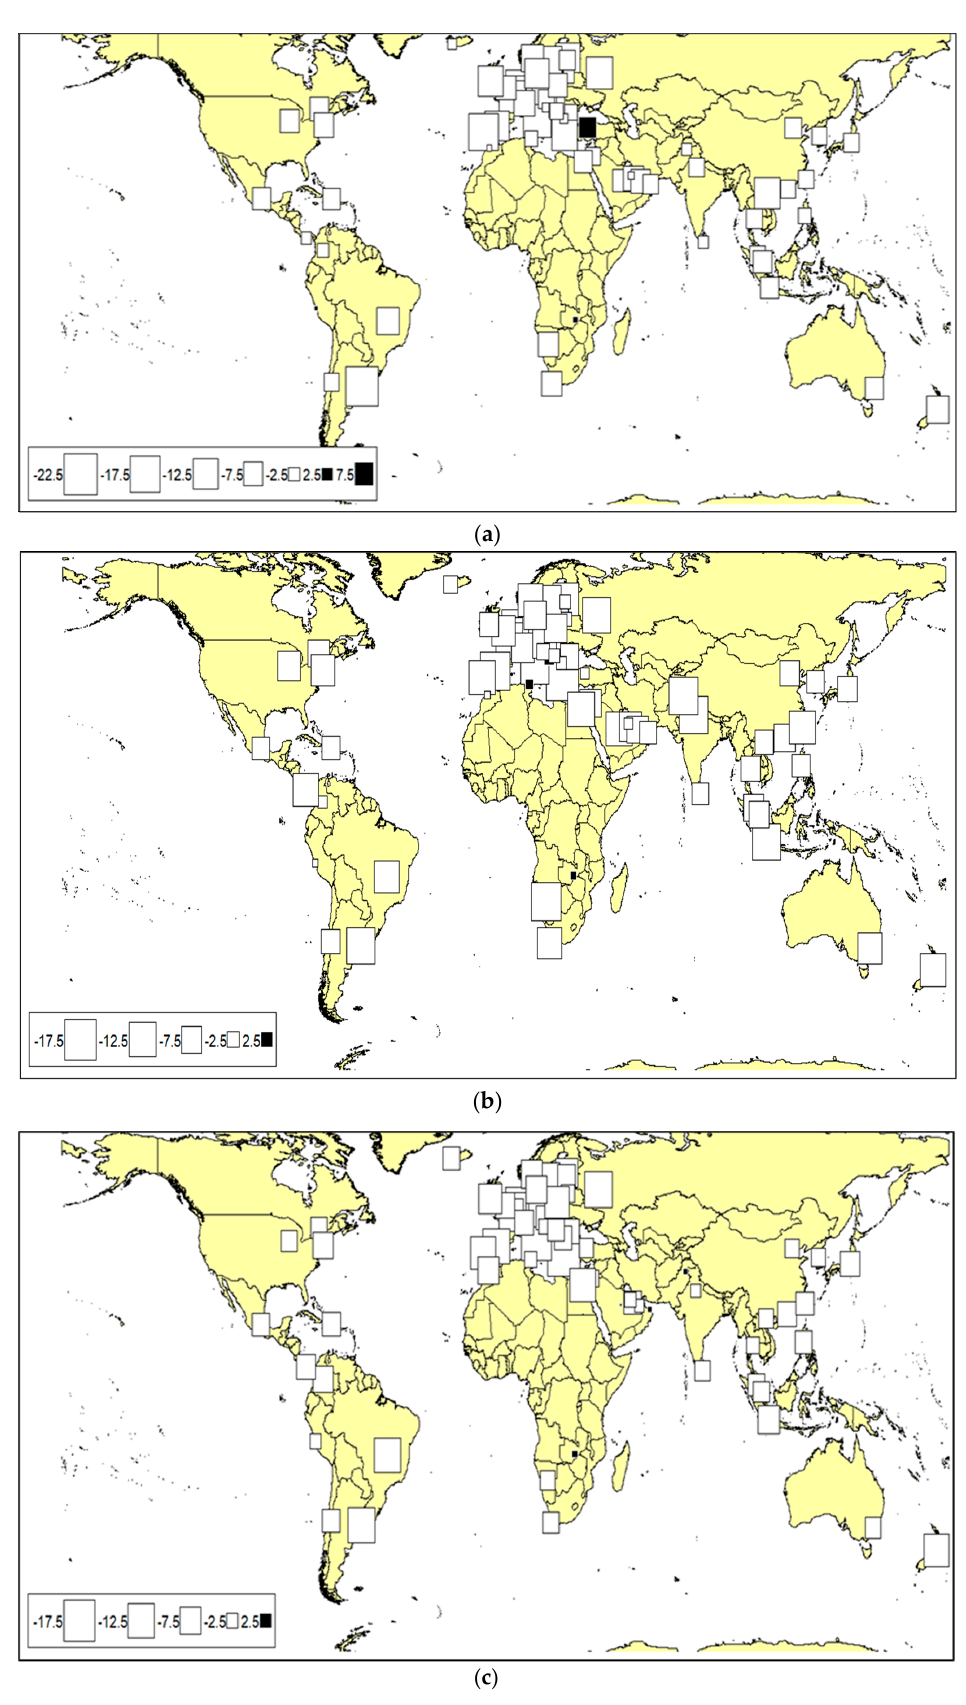
Figure A1. Distribution of eigenvalues based on FPCA: ( a ) period 1; ( b ) period 2; ( c ) period 3.